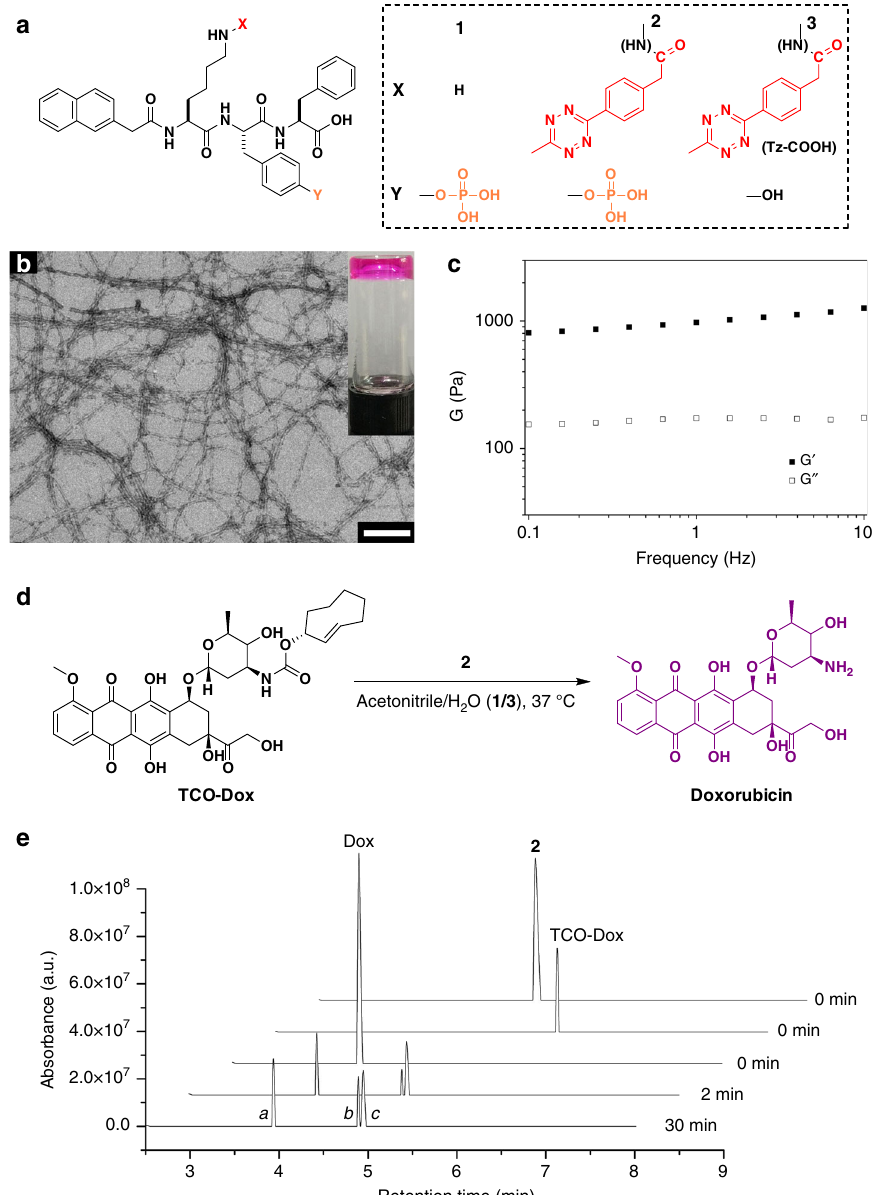
Fig. 2 Tetrazine-bearing assembly molecules and prodrug activation in vitro. a Structures of NapKYpF ( 1 ), the tetrazine bearing self-assembly precursor NapK(Tz)YpF ( 2 ) and dephosphorylated assembly molecule NapK(Tz)YF ( 3 ). b TEM and optical (inset) images of hydrogel 3 . Scale bar, 200 nm. c Frequency sweep of the dynamic storage modulus ( G ′ ) and loss modulus ( G ″ ) of hydrogel 3 . d Activation of TCO-Dox by 2 in vitro. e UPLC trace (detected at 233 nm) recording the activation of TCO-Dox by 2 with Dox, 2 , and TCO-Dox as references (Peak a is Dox, peak b is the TCO adduct, peak c is 2